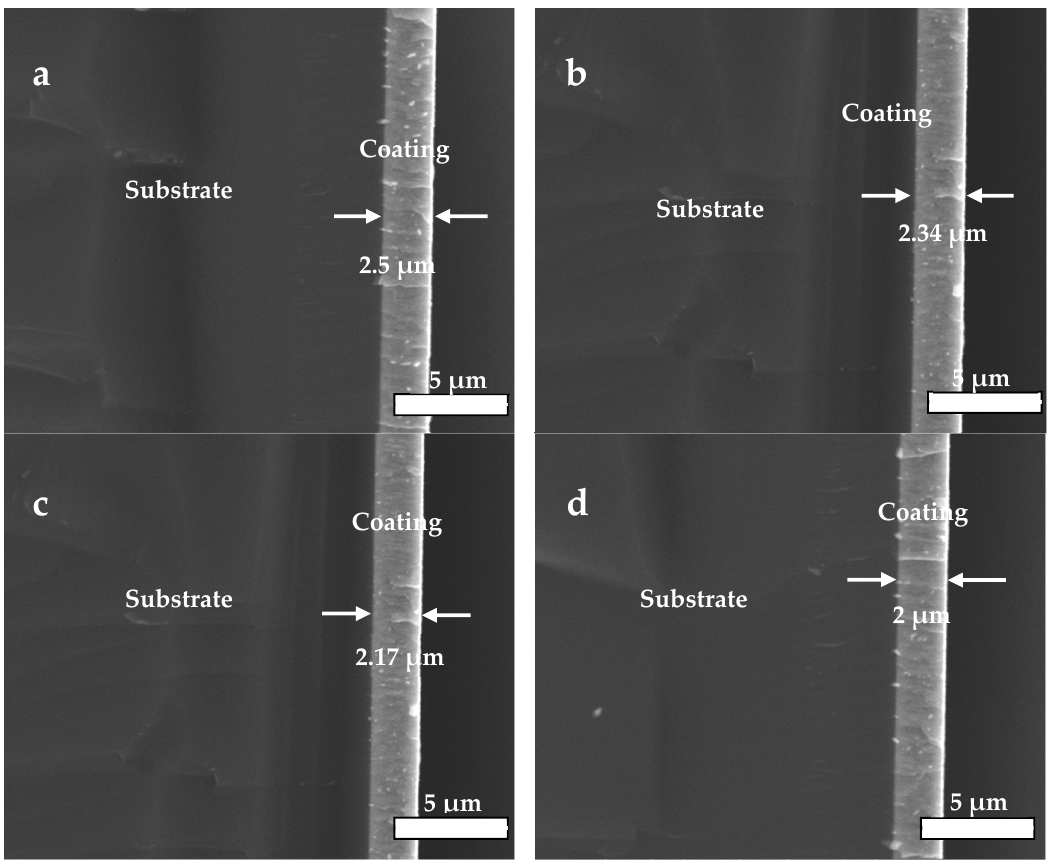
Figure 5. Cross-sectional SEM images of HfC coatings deposited at different bias voltages: ( a ) 0 V, ( b ) − 100 V, ( c ) − 150 V, and ( d ) − 200 V.